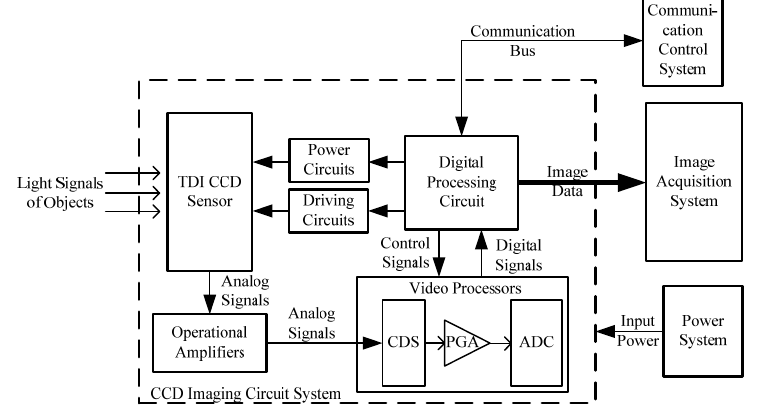
Figure 2. Test block diagram of the TDI CCD imaging system. Table 1. The main technical indicators of the imaging system.